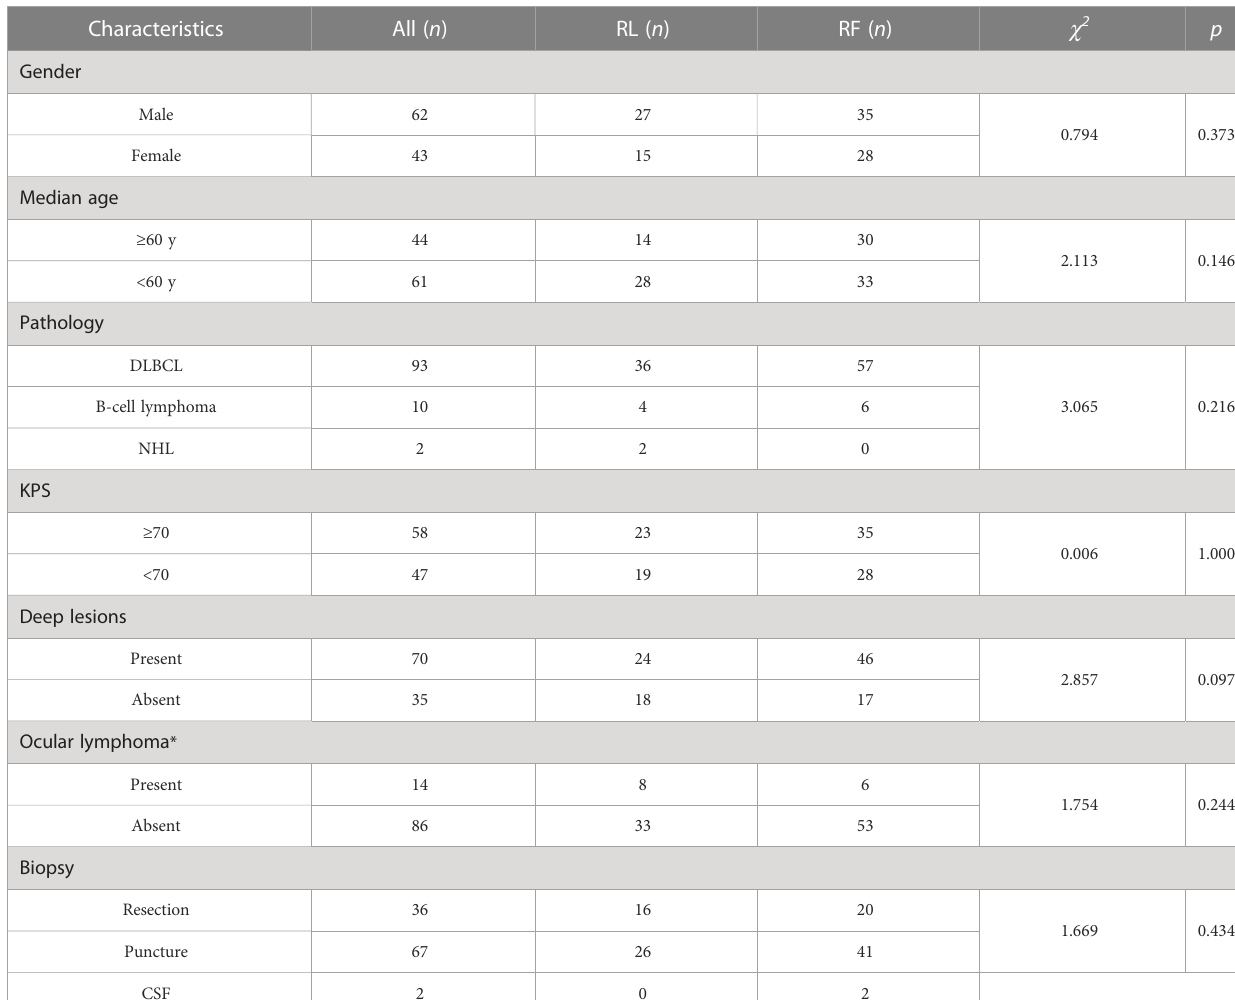
TABLE 1 Clinical and tumor characteristics.